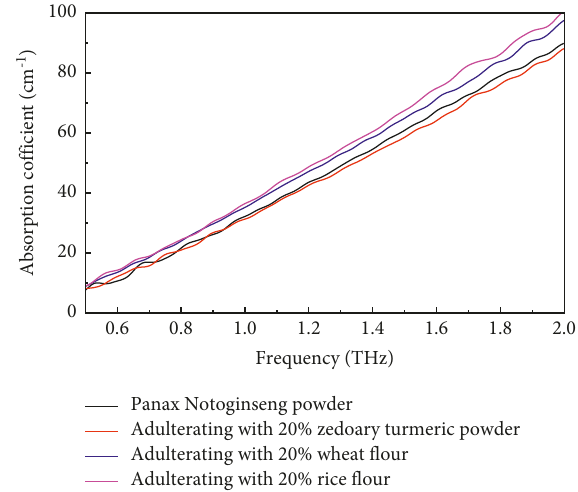
Figure 2: The absorption coefficient of four types of samples in 0.5–2 THz.